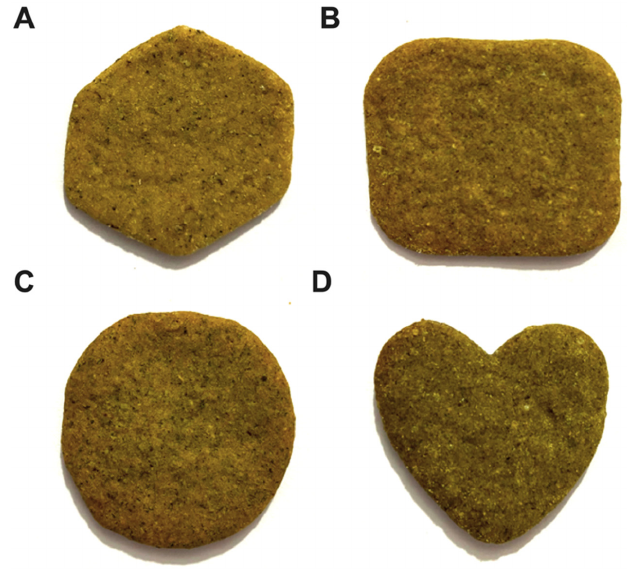
Figure 1. Representative photographs of different formulations of cookies. ( A ) Ch5:A20: 40 g of wheat flour + 5 g of chaya flour + 20 g of amaranth flour. ( B ) Ch10:A15: 40 g of wheat flour + 10 g of chaya flour + 15 g of amaranth flour. ( C ) Ch15:A10: 40 g of wheat flour + 15 g of chaya flour + 10 g of amaranth flour. ( D ) Ch20:A5: 40 g of wheat flour + 20 g of chaya flour + 5 g of amaranth flour.